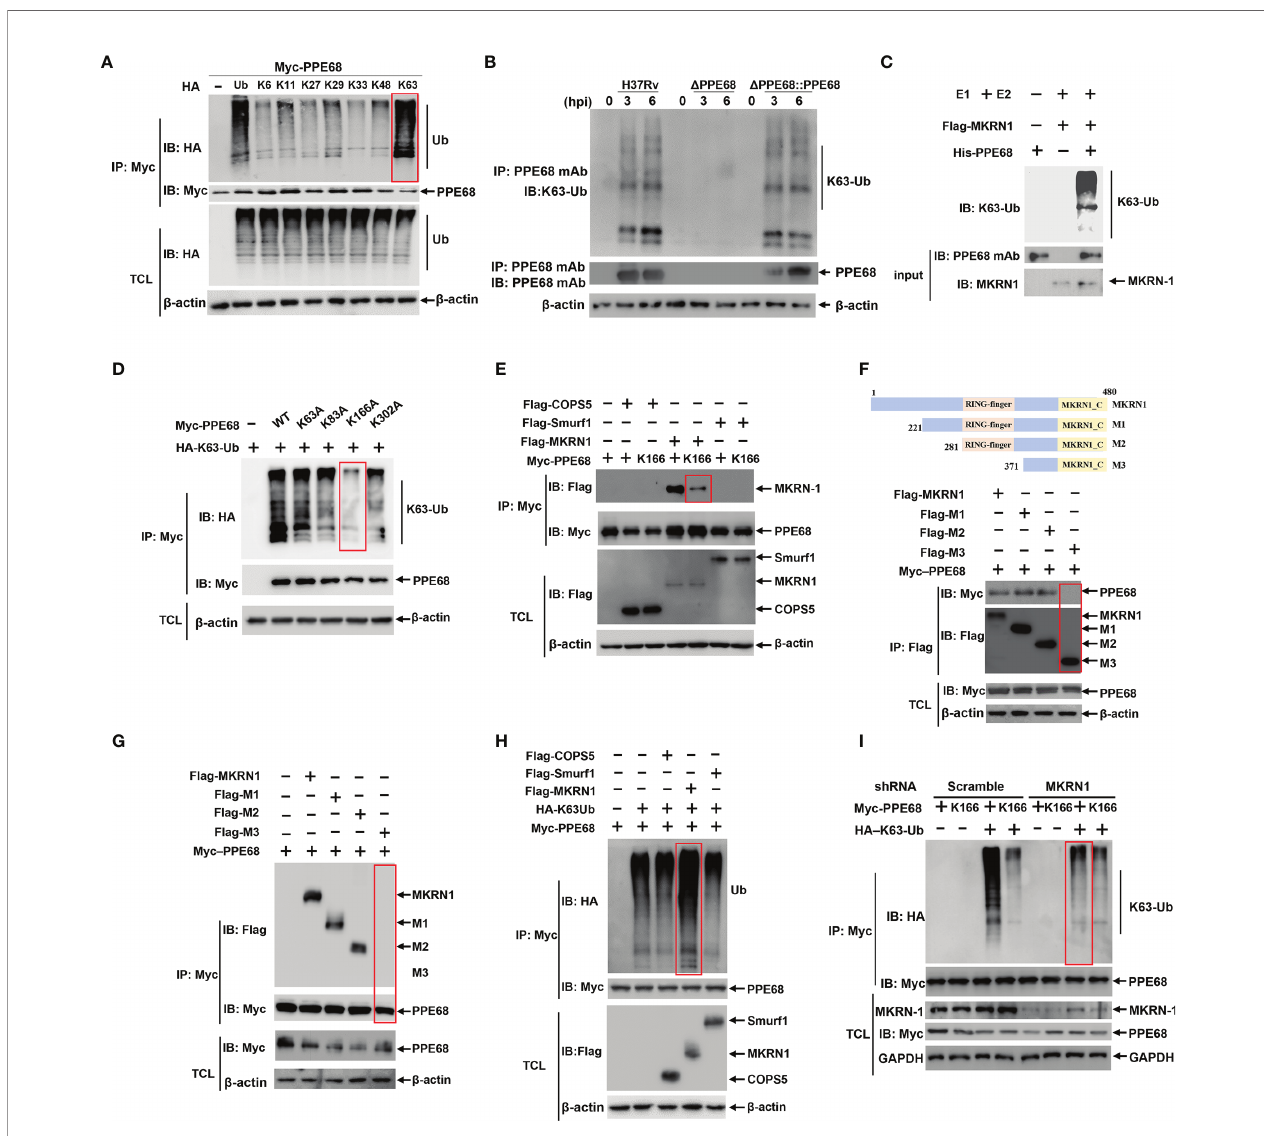
FIGURE 2 | MKRN1 interacts with PPE68 and promotes the attachment of K63-linked ubiquitin chains to K166 of PPE68. (A, D-I) HEK293T cells were transfected with the indicated plasmids for 24 h, and then cell lysates were analyzed by immune-precipitation (IP) and Western blot with anti-HA, anti-Myc and anti-Flag antibodies. PPE68 ubiquitination status (A) . PPE68 critical ubiquitination site at K166 (D) . MKRN1 interacts with PPE68, but not PPE68 K166 mutant (E) . MKRN1 critical binding domain for PPE68 (F, G) . MKRN1 overexpression promotes ubiquitination for PPE68 (H) . PPE68 could not be ubiquitinated after silencing MKRN1 (I) . (B) PPE68 protein in H37Rv and Rv D PPE68::PPE68 could be ubiquitinated. BMDMs were infected with H37Rv, Rv D PPE68 or Rv D PPE68::PPE68 (MOI=10) for the indicated time course, and then cell lysates were analyzed by IP with an anti-PPE68 mAb and Western blot with an anti-PPE68 mAb and anti-K63 Ub antibodies. (C) Western blot analysis of PPE68 ubiquitination in vitro . The puri fi ed His-PPE68 and Flag-MKRN1 proteins, and the ubiquitin, E1 and E2 ligases were mixed for ubiquitination assay. The mixtures were incubated at 37°C for 90 min and analyzed via Western blot with an anti-K63 Ub antibody. TCL, total cell